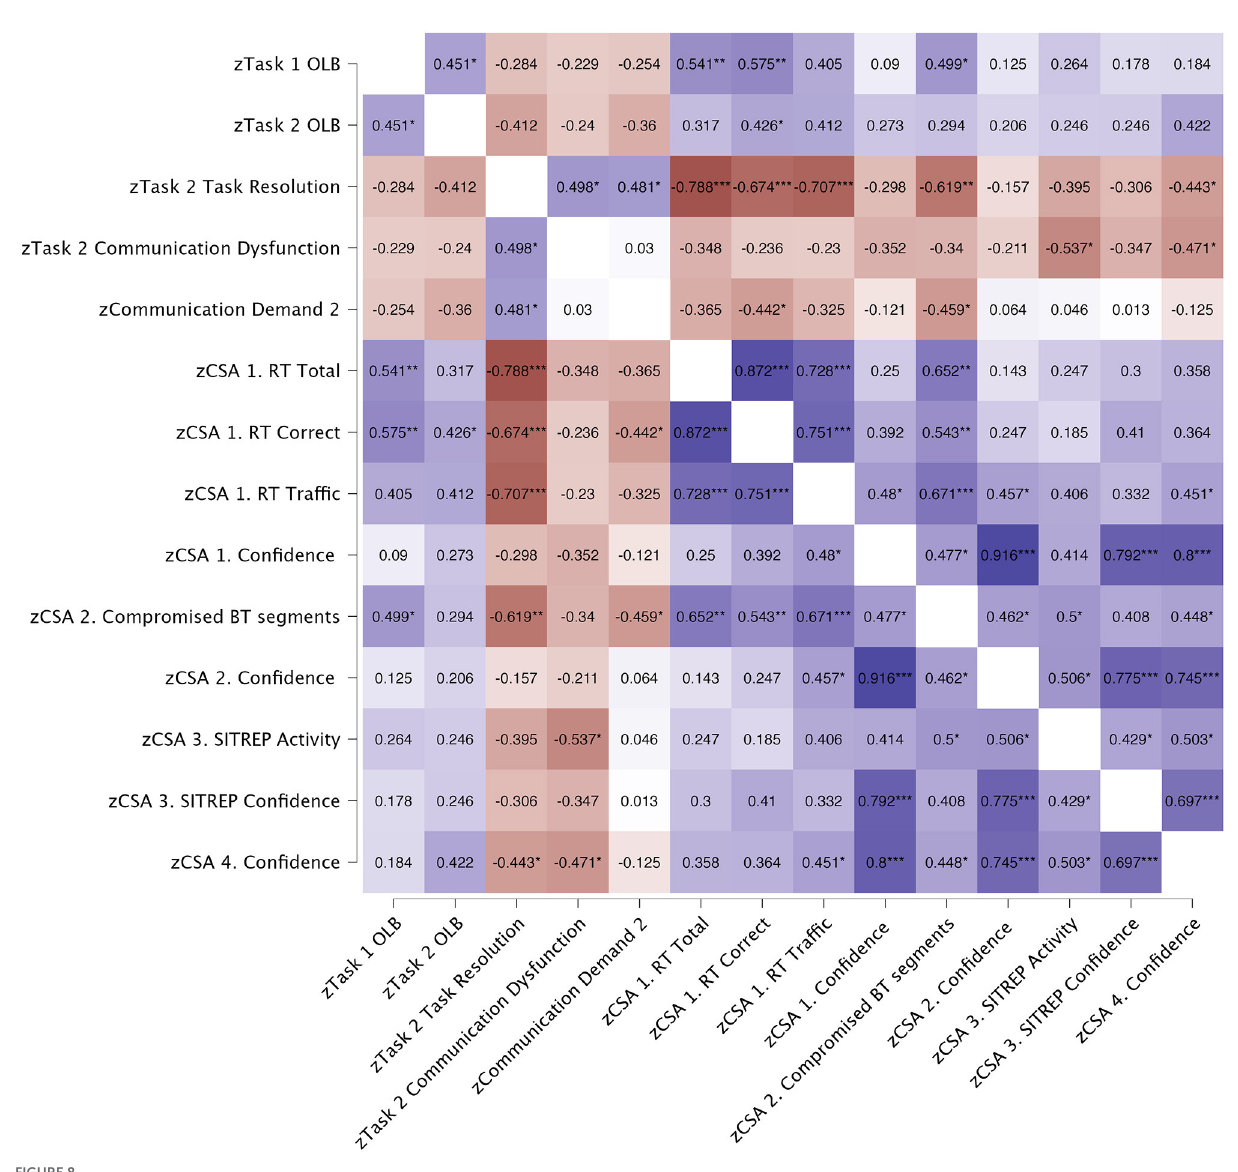
FIGURE8 Heat map showing results from Spearman ( ρ ) correlations. All correlations are 2-tailed. Blue color indicates positive correlations. Red color indicates negative correlations. * p < 0.050, ** p < 0.010, *** p < 0.001. OLB, Orient, Locate, Bridge (Knox et al., 2018); CSA, Cyber situational awareness; RT, Red team; BT, Blue team; SITREP, Situational